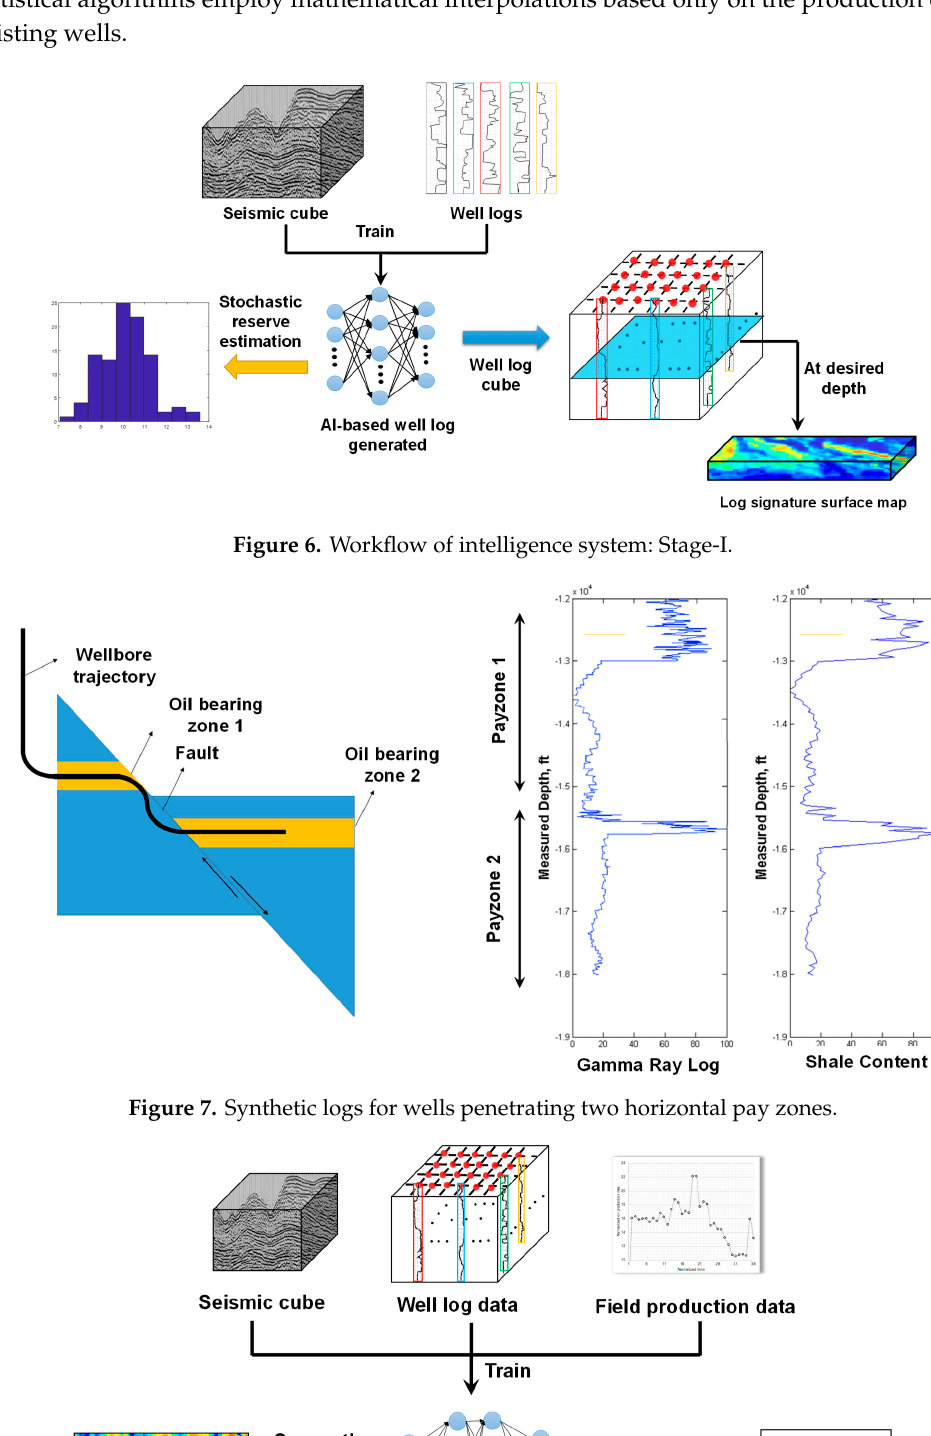
Figure 8. Workflow of intelligence system: Stage-II.